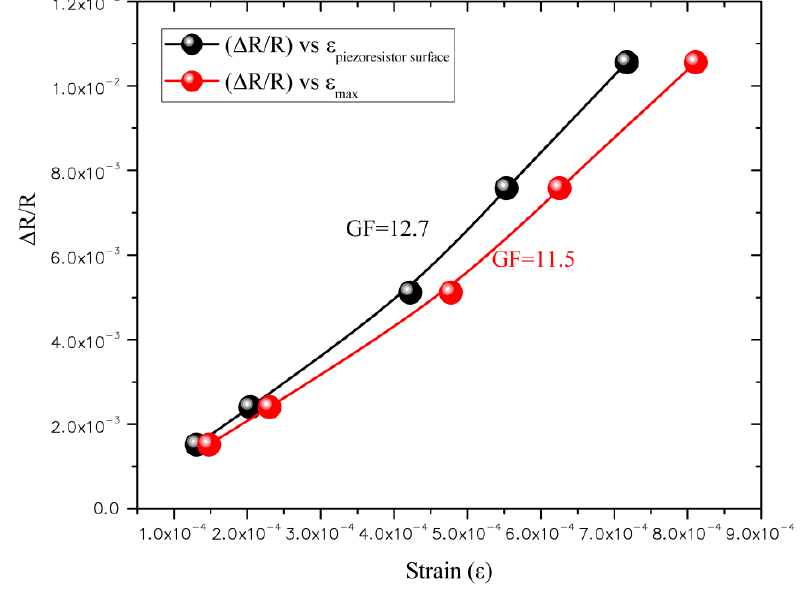
Figure 6. Relative change in resistance ( ∆ R/R) as a function of strain ε . Table 3. Parameters and results of the works reported on ZnO piezoresistive thin